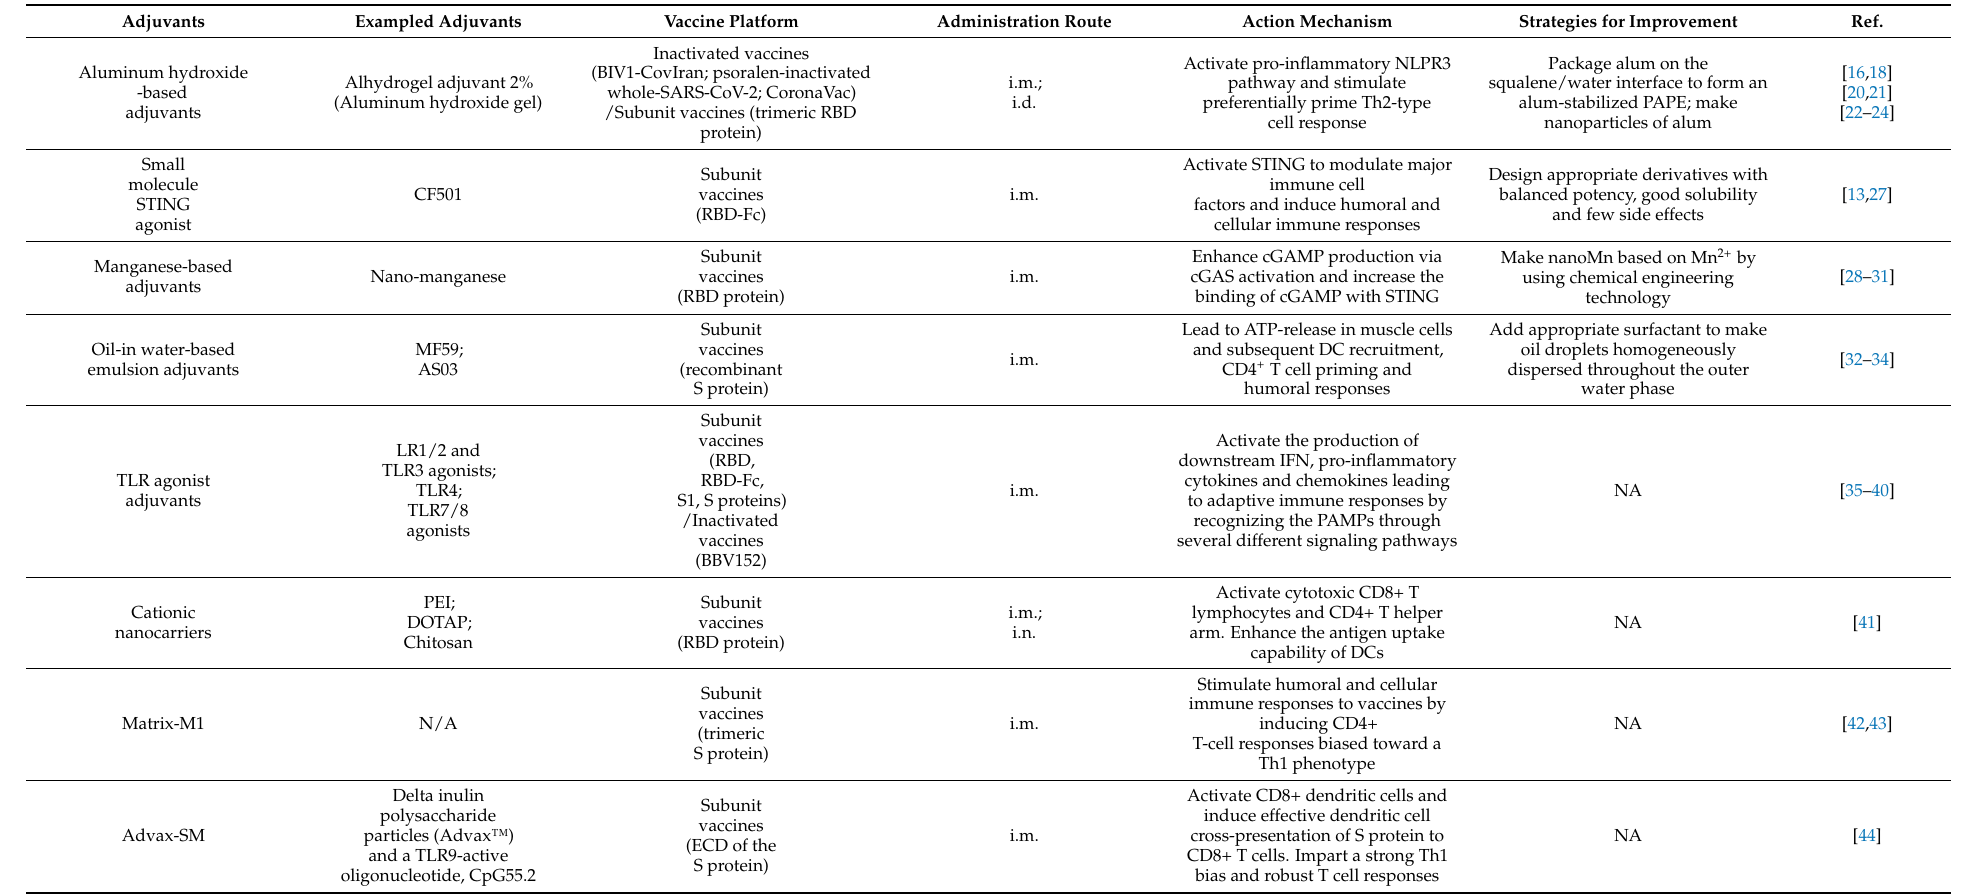
Table 1. Adjuvants’ mechanism of action, strategies for enhanced improvement and their status of clinical